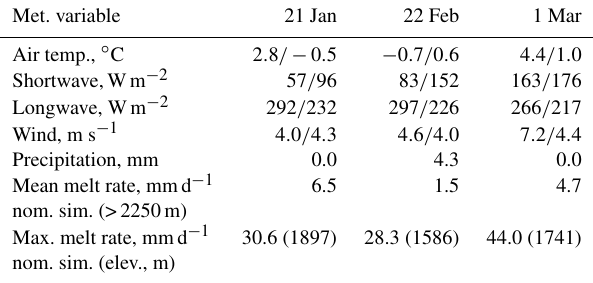
Table 3. Mean daily values of hourly measured meteorological vari- ables (nominal mean) during the three mid-winter melt events in 2009 (see Fig. 10) compared to the average conditions measured at eight stations >2250ma.s.l. computed on 11 days centered on the event dates, averaged over the three years of the study. Precipitation is reported as the daily sum of measured values. Melt rates simu- lated in the nominal case are reported as the mean value computed over all grid elements >2250ma.s.l. and the maximum value over the full domain with the corresponding